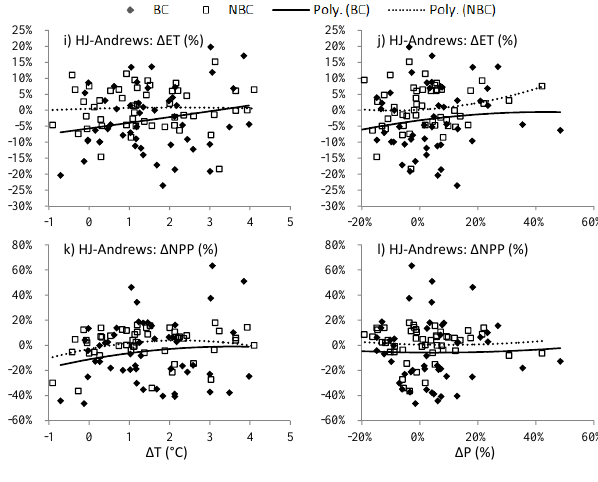
the 2050s, indicating a primarily energy-limited ET regime (Liu et al.,